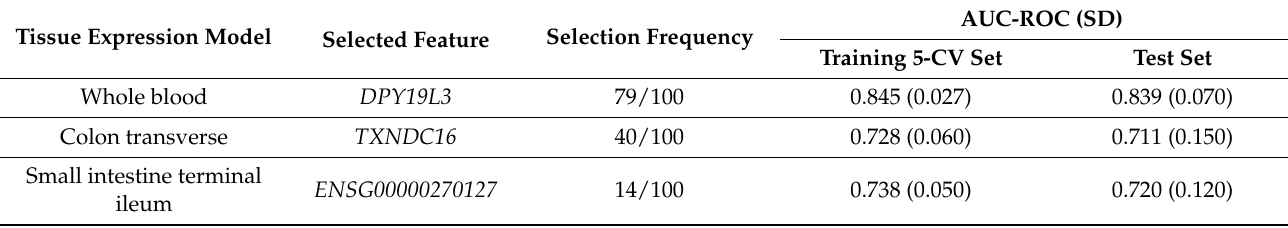
Table 2. Most frequently selected single feature for each tissue expression imputation model and its performance in classifying NDR vs.